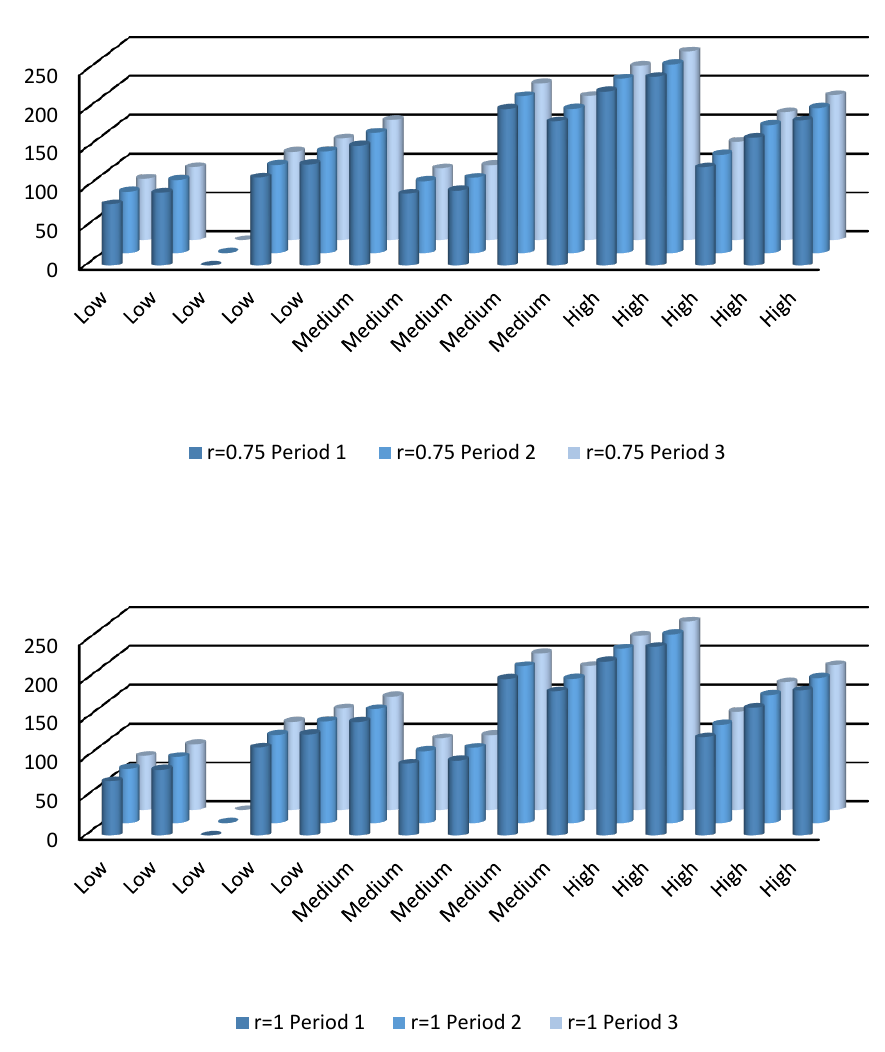
Figure 9. Water shortage for industrial users under different acceptance degrees.